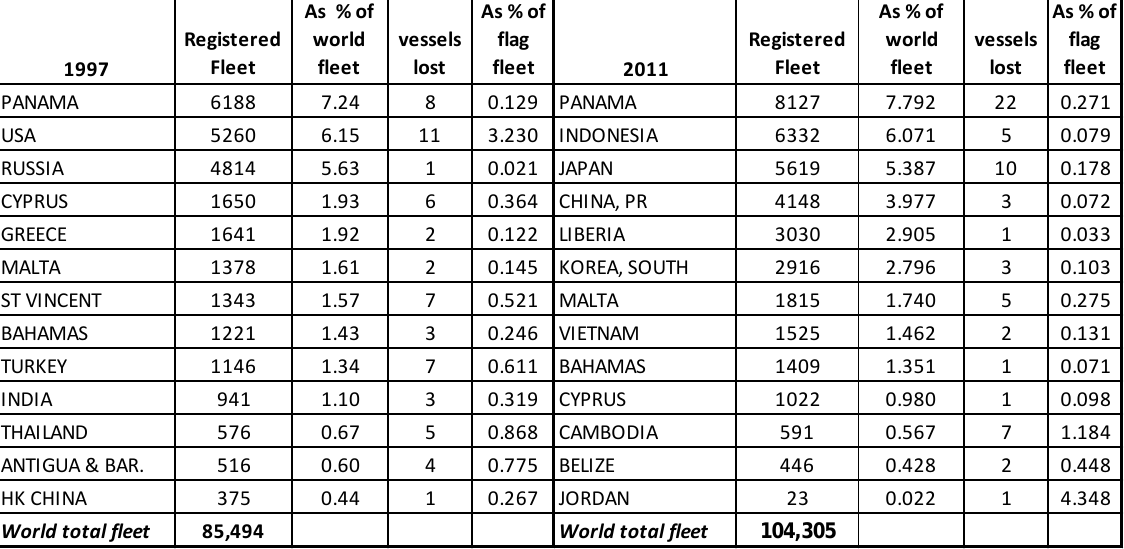
Table 3 : Total of world’s registered fleet as recorded losses of >10,000gt in 1997 and